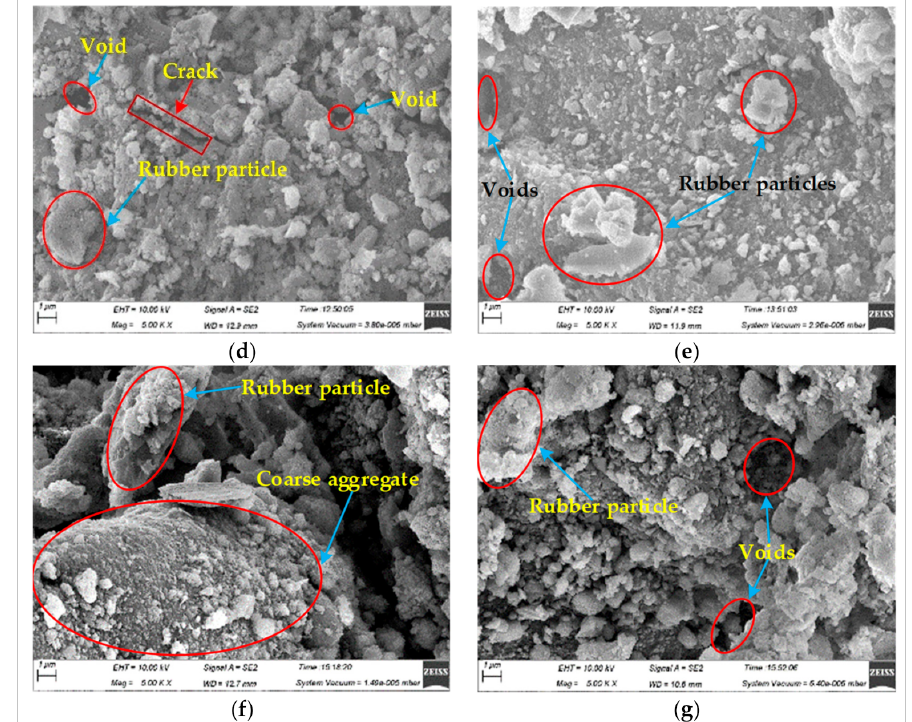
Figure 15. Micrographs of samples obtained by SEM: ( a ) Rubber content 0% (control group), ( b )